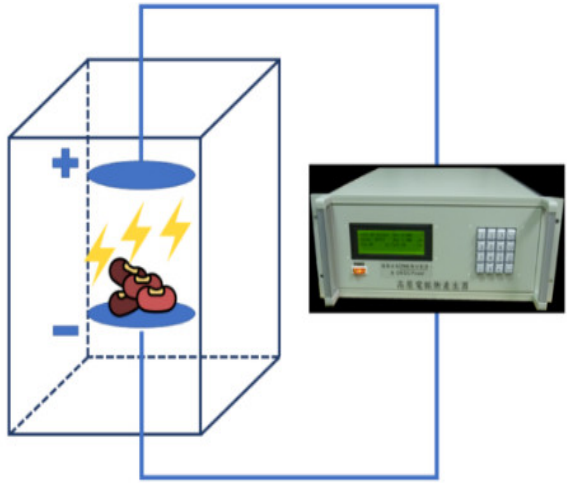
Figure 2. Experimental setup for high-voltage electric field treatment. An electric field power supply and a test chamber consisted of two electrodes between which the electric field was generated.